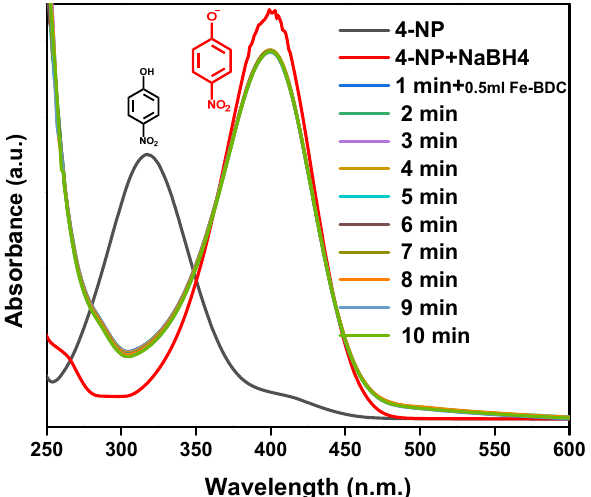
Figure 8. UV-Vis spectra of the catalytic reduction of 4-NP to 4-AP using 0.5 mg of (Fe-BDC) catalyst.